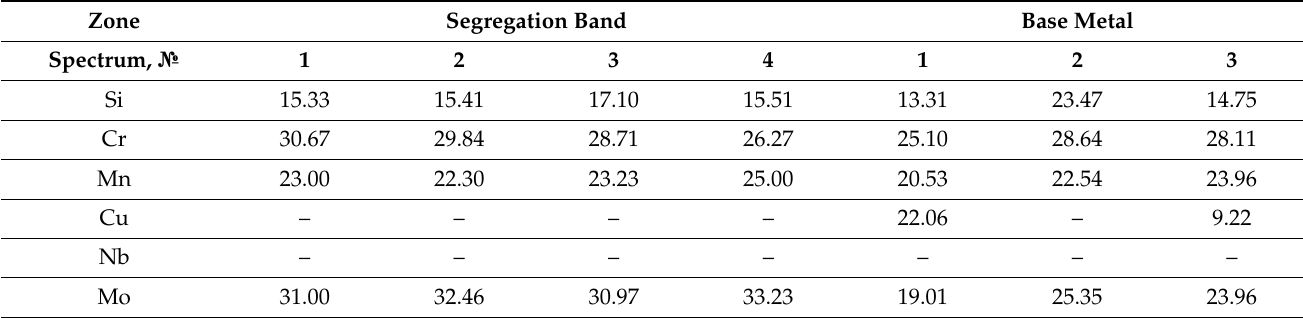
( c ) Figure 14. Microstructure in inner wall ( a ), central part ( b ) and outer wall ( c ) of CT. The CT microstructure is tempered martensite (sorbitic pearlite), evenly distributed at the outer wall and with developed segregation bands at the inner wall. Figure 15 shows the areas for determination of chemical composition, Table 6 shows a comparison of the chemical composition of the segregation zone and in the base metal of the CT sample.